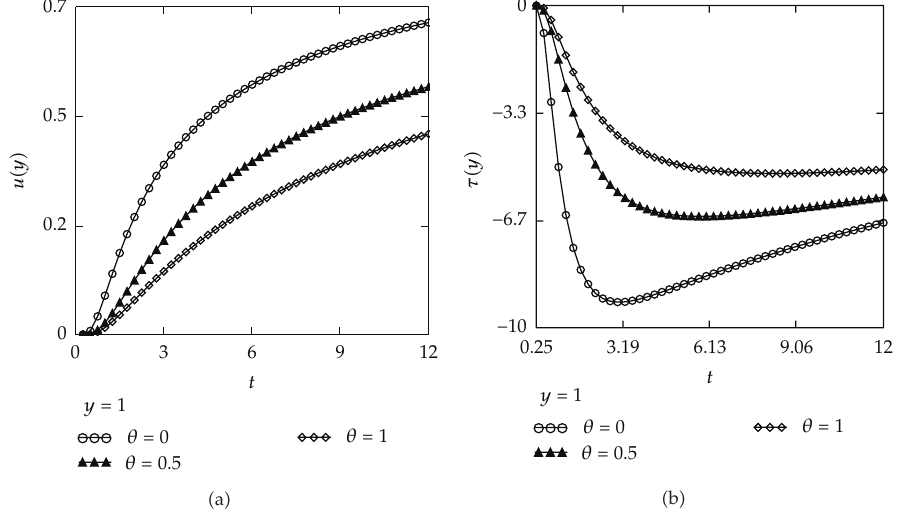
Figure 3: Profiles of the velocity field u (cid:4) y,t (cid:5) and the shear stress τ (cid:4) y,t (cid:5) for fractional Maxwell fluid given by (cid:4) 4.7 (cid:5) and (cid:4) 4.15 (cid:5) , for U (cid:9) 1, y (cid:9) 1, ν (cid:9) 0 . 379, μ (cid:9) 33, λ (cid:9) 1 . 5, α (cid:9) 0 . 2, and di ff erent values of θ